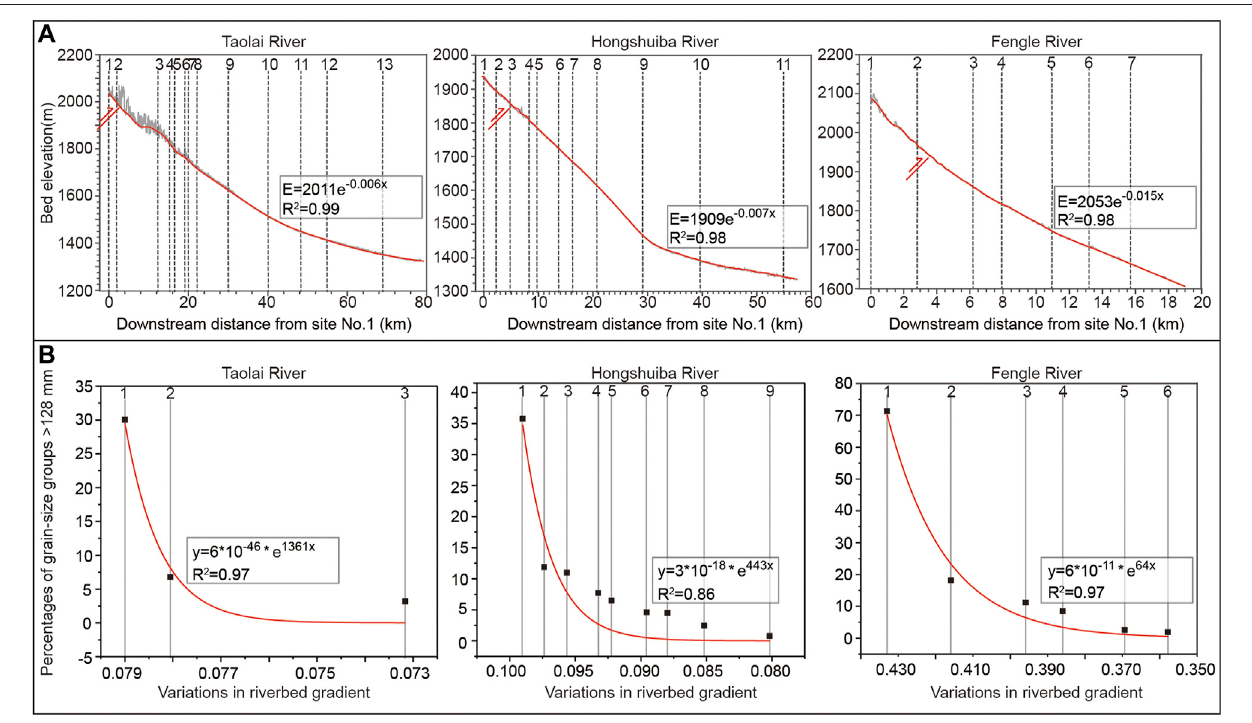
FIGURE11| Correlationanalysisbetweenthepercentagesofgrain-sizegroups > 128 mmandgradientvariationsalongtheTaolai,Hongshuiba,andFengleRivers. (A) Riverbedelevationsalongthethreerivers.Theseareextractedfroma30-m-resolutionDEM,inwhichhighvaluescorrespondcloselywiththrustfaultoccurrences.At the sampling sites with some grain-size groups > 128 mm, the second derivatives ofthe three curves were then calculated as a measurementfor gradient variations. (B) Positive correlation between the obtained variations in riverbed gradient and the percentages of grain-size groups > 128 mm. There seems to be an excellent exponential relationship along the three